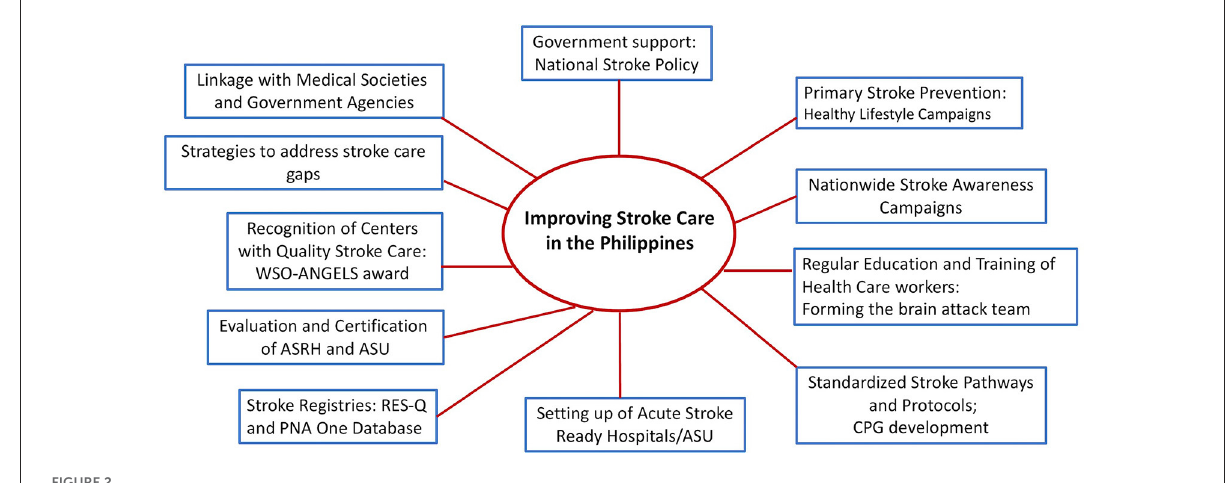
FIGURE2 Improving stroke care in the Philippines